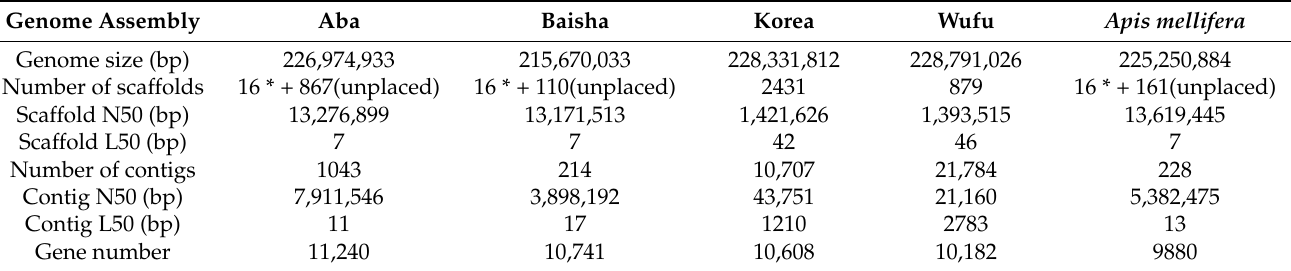
Table 1. Summary of sequencing data in Apis